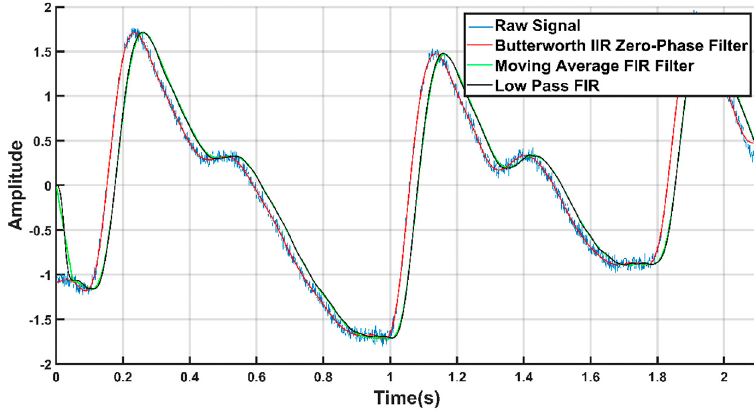
Figure 5. Filtered signals overlaid on the raw PPG signal.